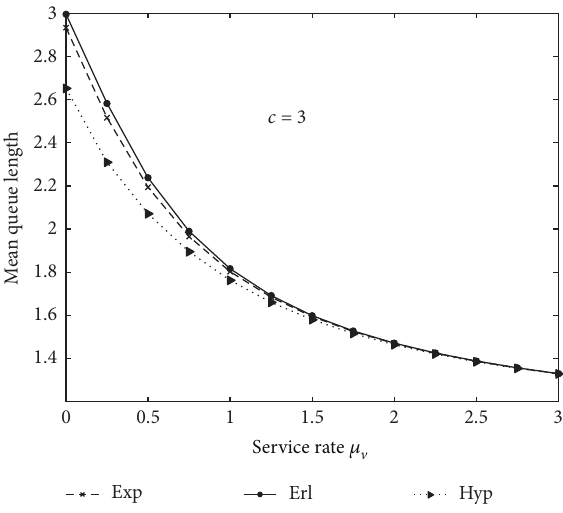
Figure 6: Mean queue length versus vacation-service rate with 𝜌 = 0.9 , 𝜉 = 1 , 𝜃 = 1 , and 𝑐 = 6 .